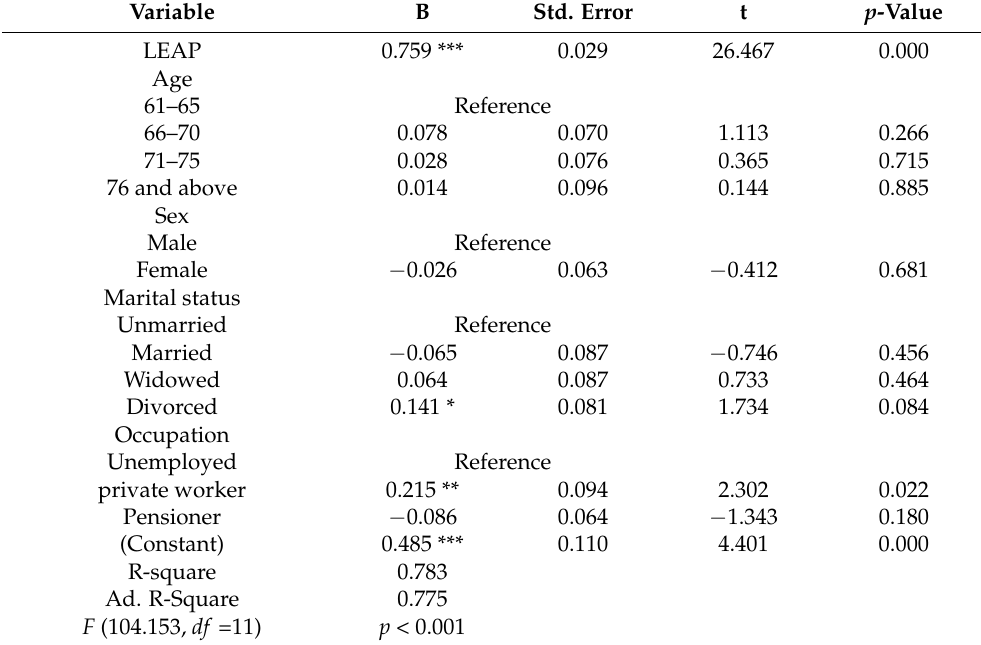
Table 4. Regression Model 1 (Dependent Variable: Healthcare Utilization). Variable B Std.